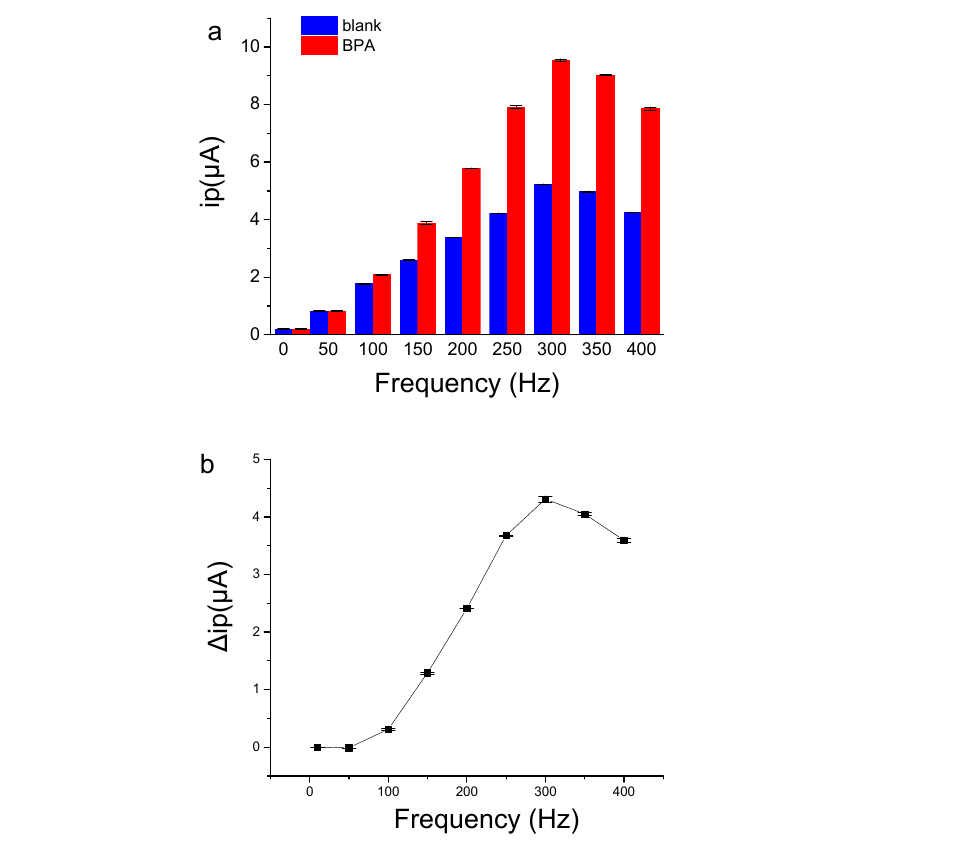
Figure 6. The effects of frequency on current signals of BP29-3’-MB electrode. ( a ) The peak current value of BP29-3’-MB electrode in the absence or the presence of 500 μΜ BPA. ( b ) The peak current signals change caused by 500 μΜ BPA. The binding buffer contained 25 mM Tris-HCl (pH = 8.0), 100 mM NaCl, 25 mM KCl, and 10 mM MgCl 2 .